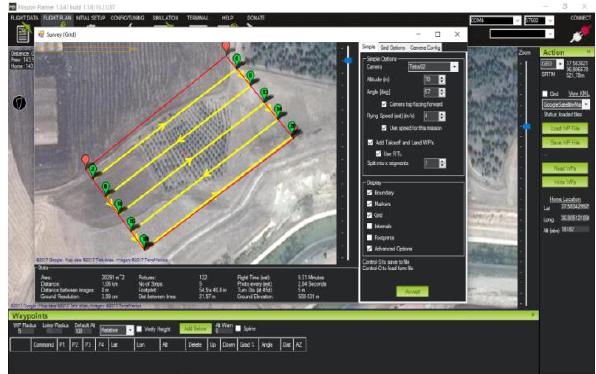
Figure 1. Mission planner software interface (flight